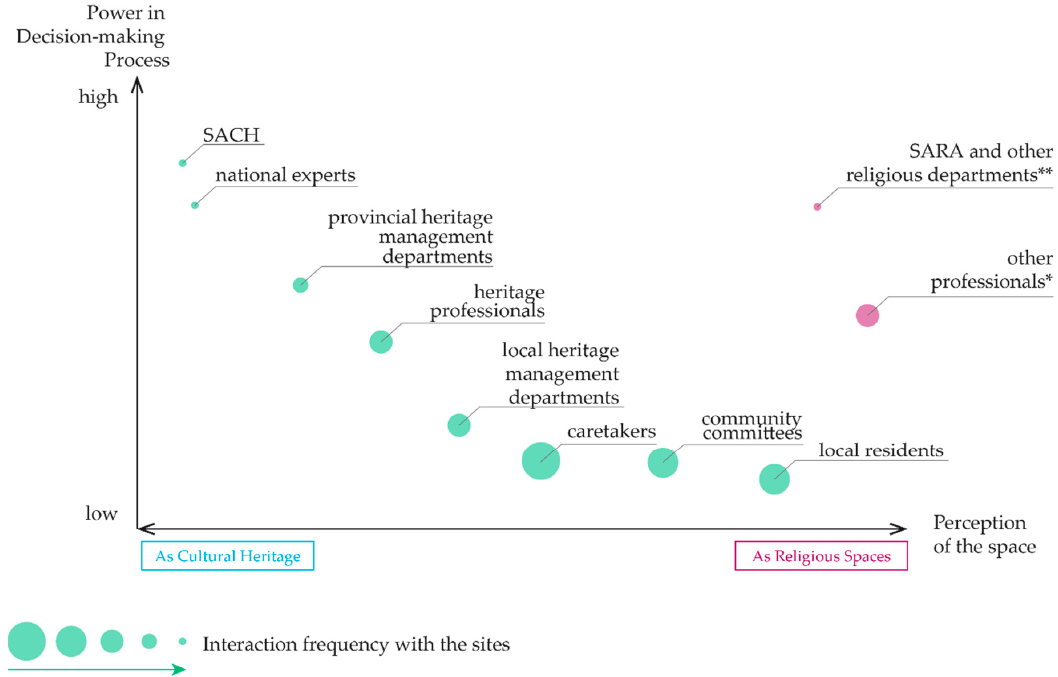
Figure 7. Power-preference relationship of stakeholders. * Other professionals include those who specialise in religious studies, ICH, or other relevant studies revolving the sites. They are seldom consulted in the decision-making process. ** Although SARA and other religious departments might hold higher power on the administrative level compared to some of the other stakeholders, they are not usually included in the decision-making process because these sites are considered primarily as PCHS.